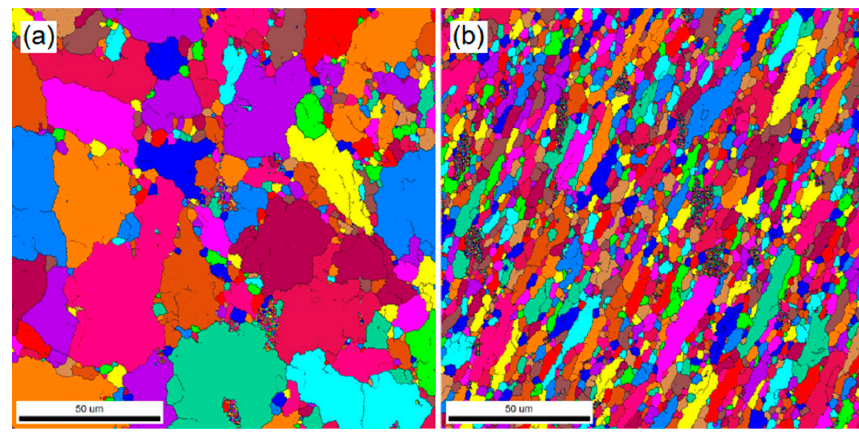
Figure 5. Electron back scattered diffraction (EBSD) micrographs of ( a ) the base and ( b ) the shallow cryogenic treatment (SCT) sample [56].